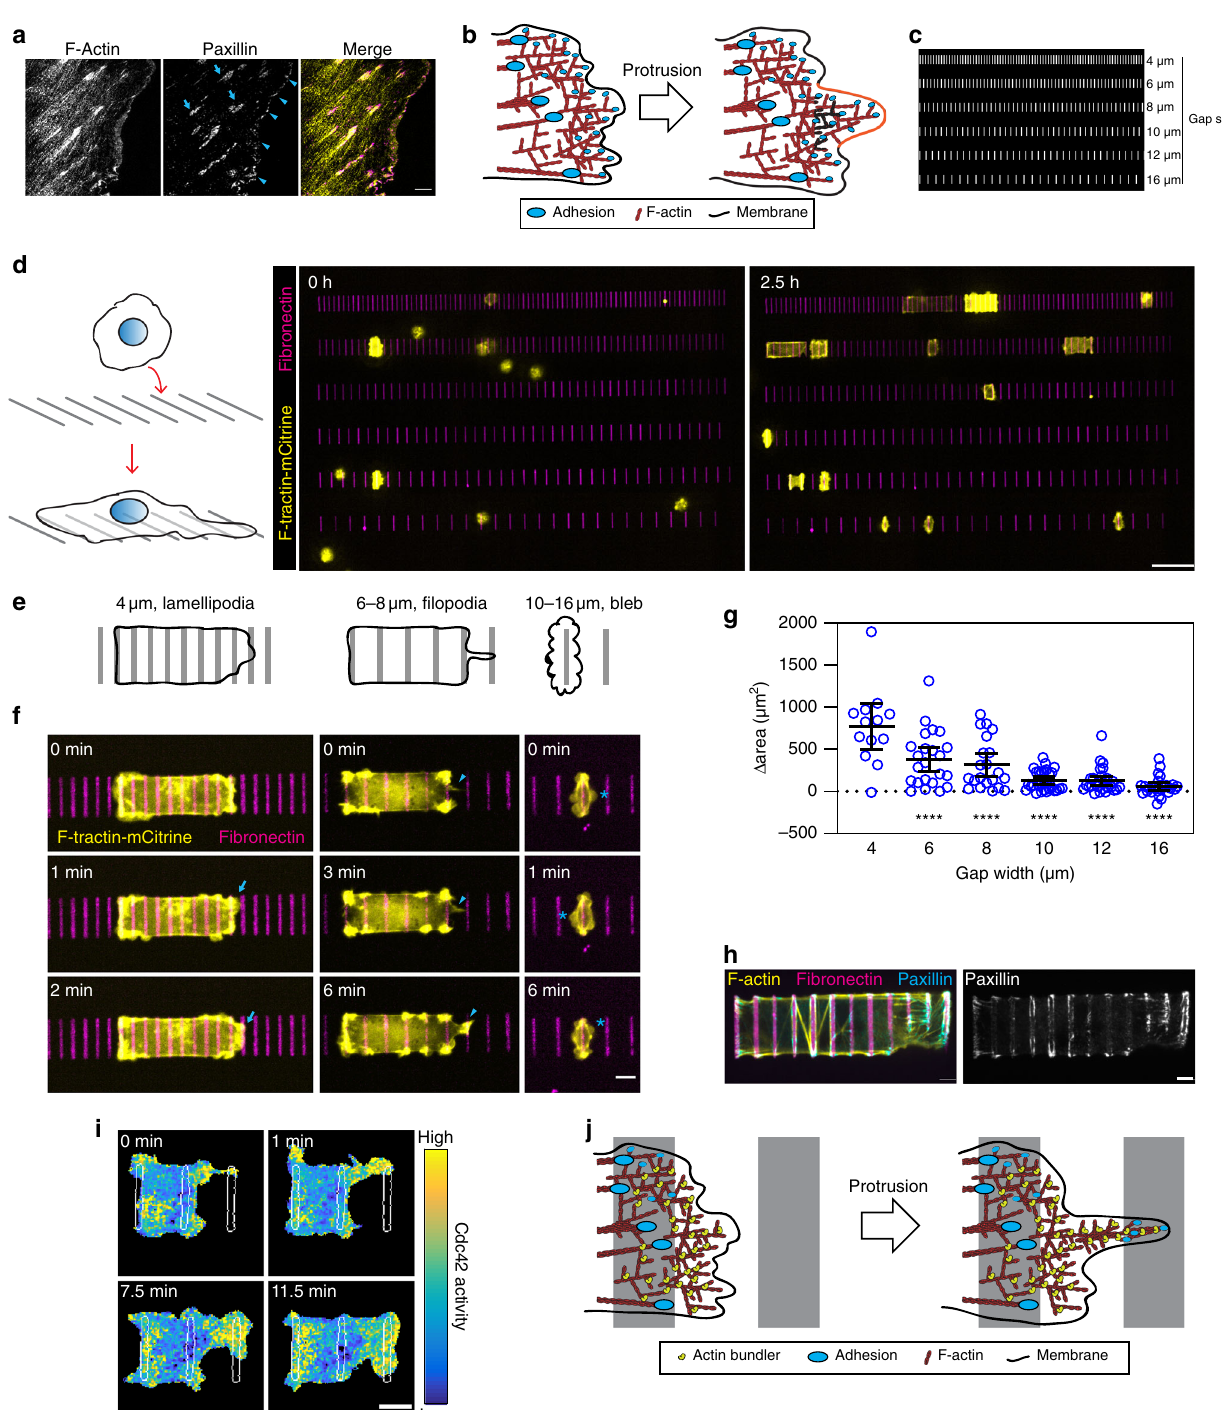
T-Plastin is an ancient actin bundler required for effective lamellipodial protrusion . To determine whether actin-bundling protein(s) promote membrane protrusion across gaps in ECM we fi rst examined the localizations of 7 candidates that were selected based on available RNA sequencing datasets of endothelial cells (Fig. S2a) 25 . Out of these endothelial actin-bundling proteins, only T-Plastin was selectively localized to lamellipodia in HUVEC (Figs. 2a and S2b). Moreover, T-Plastin was also enriched in lamellipodia of mouse melanoma cells (B16-F1) and human epithelial cells (RPE-1) (Fig.